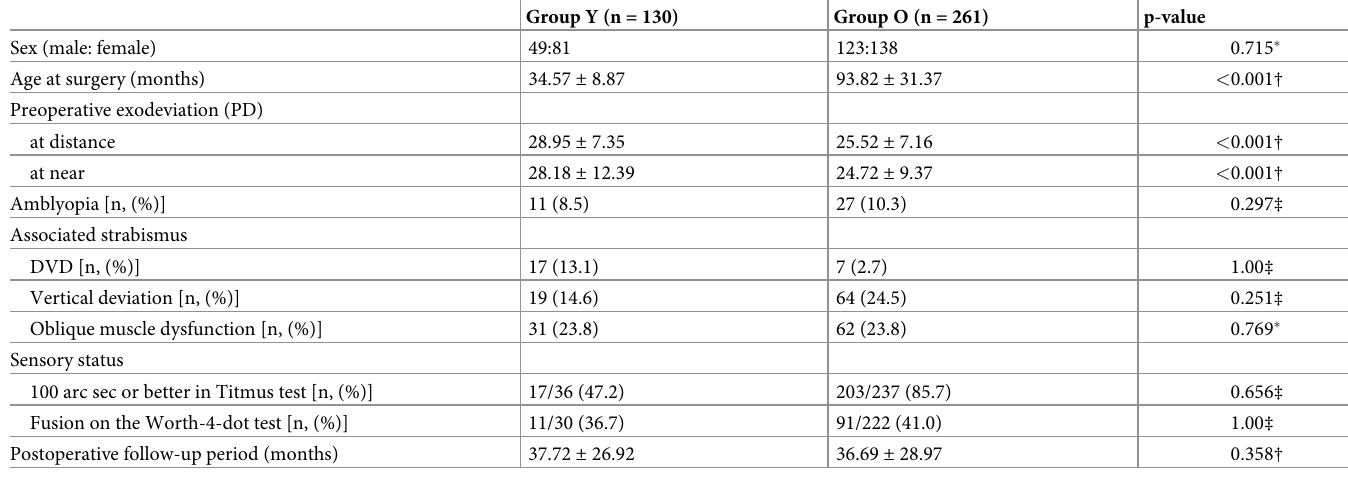
Table 2. Demographic characteristics of enrolled